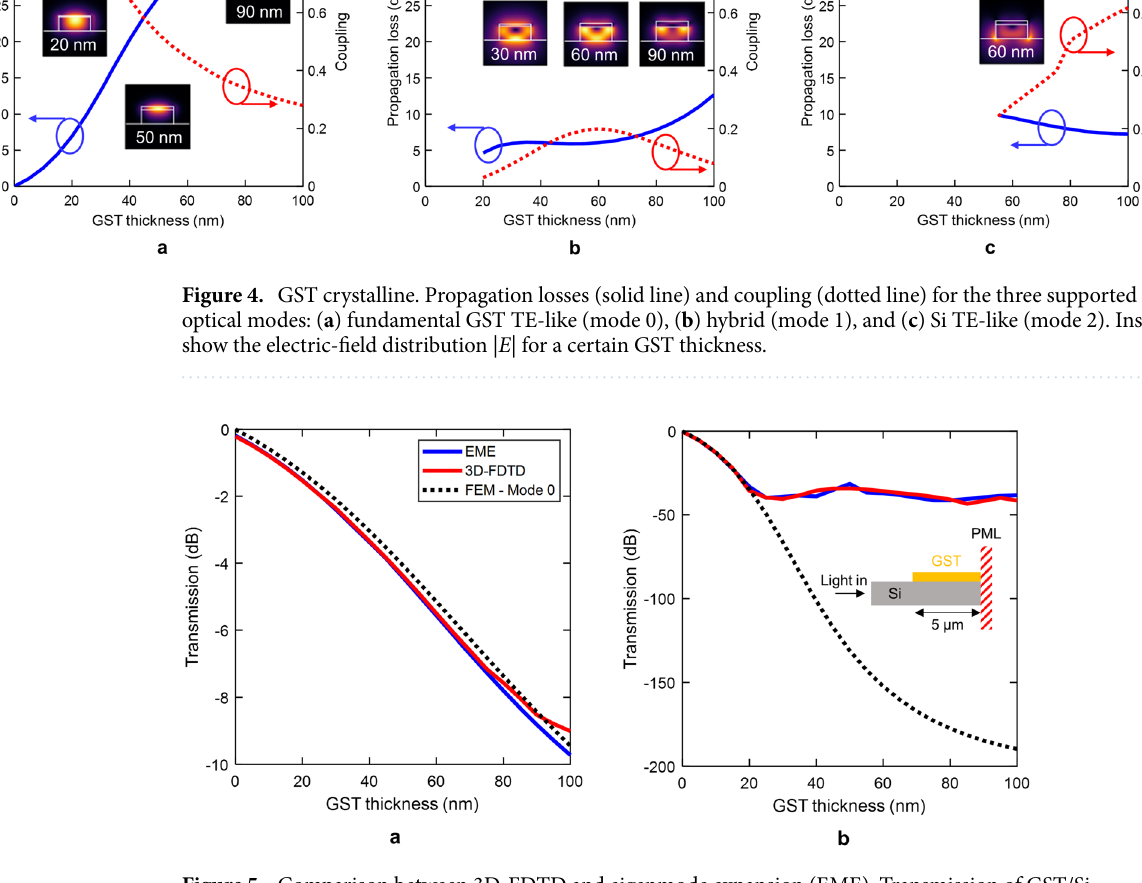
Figure 5. Comparison between 3D-FDTD and eigenmode expansion (EME). Transmission of GST/Si waveguide as a function of the GST thickness in the ( a ) amorphous and ( b ) crystalline state. Simulations were carried out for a step discontinuity between a silicon and GST/Si waveguide. The fundamental TE mode of the silicon waveguide impinges into a GST/Si waveguide ending in perfectly matched layer (see inset). Results were obtained for a 5 µ m-long-GST/Si waveguide. The dotted line stands for the transmission considering a perfect coupling of the fundamental (mode 0) TE mode into the GST/Si